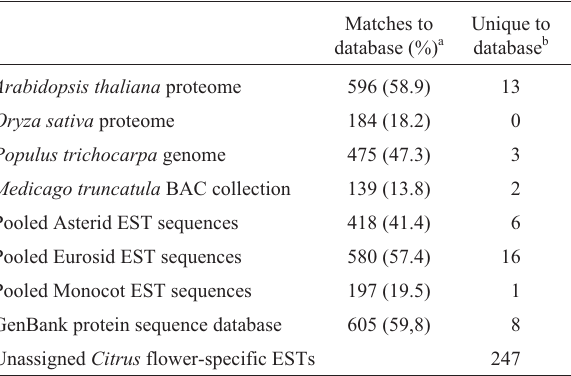
Table 1 - Functional classification of the Citrus putative flower-specific transcripts. Match Arabidopsis MIPS a